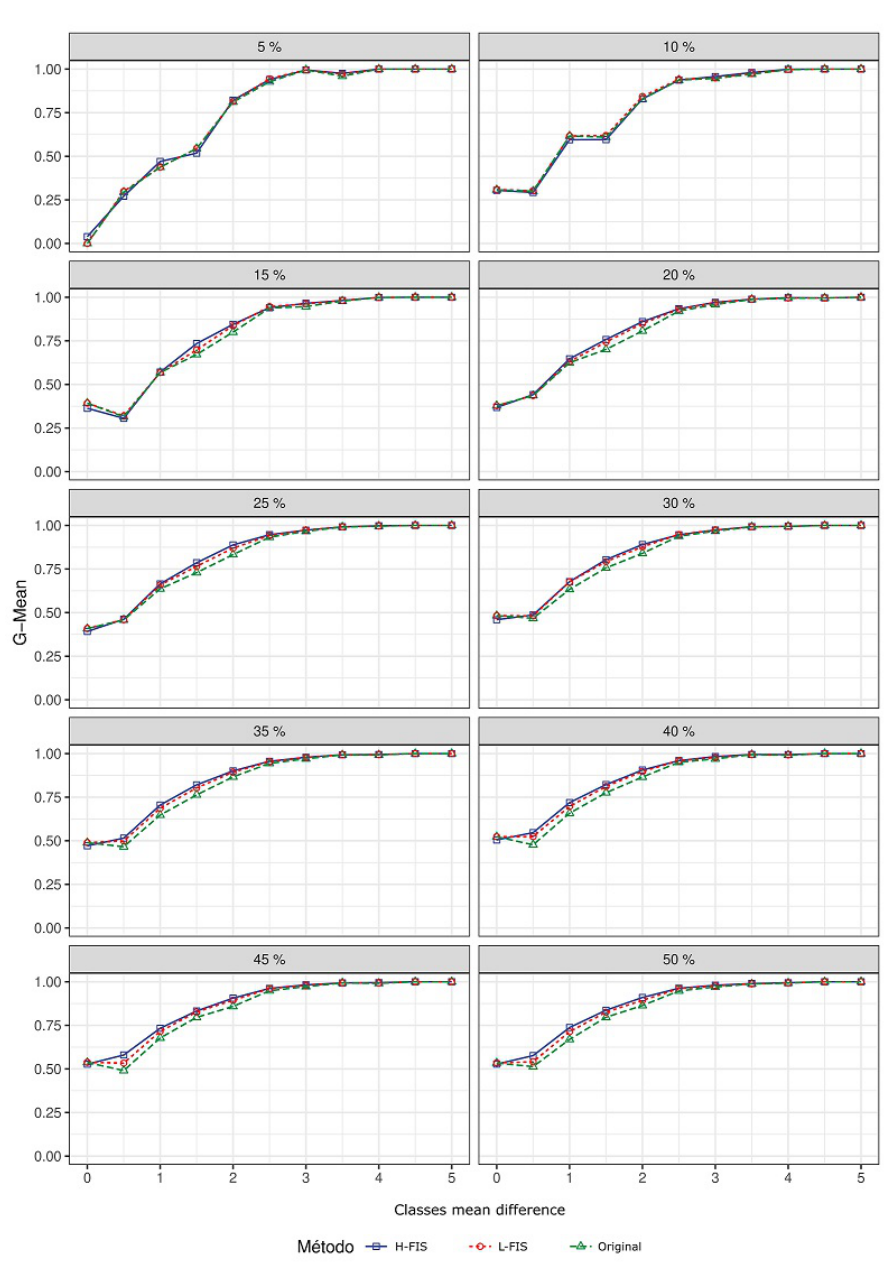
Figure 4. Comparison of G-Mean values on artificial bases for the methods developed in this work and 1NN without pre-processing (baseline). The grouping was done by proportion of the positive